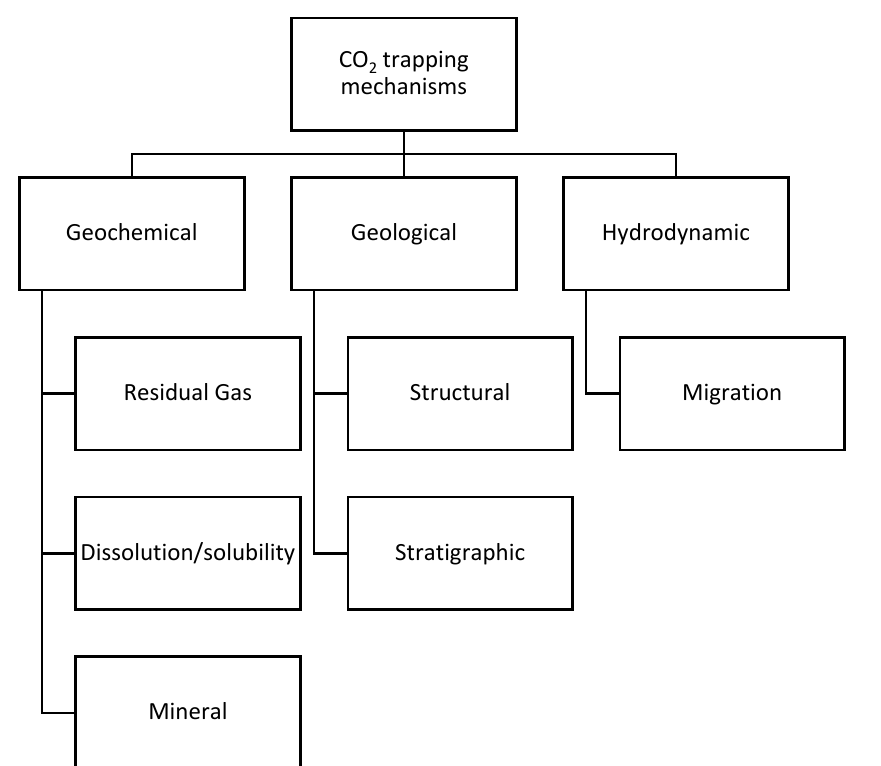
Figure 2. CO 2 trapping mechanisms.